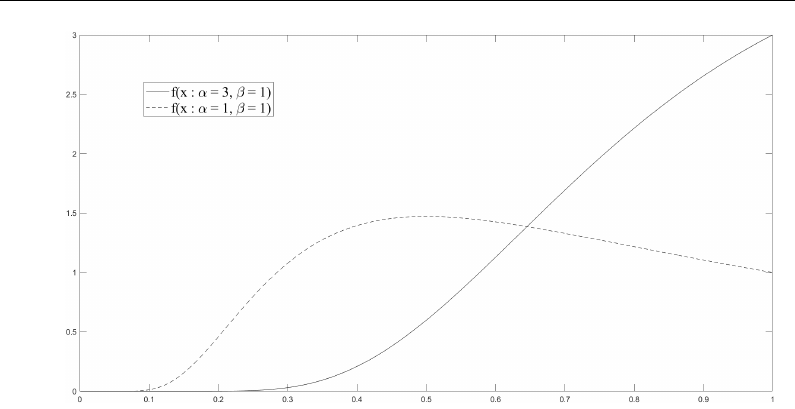
Figure 2 – Density functions of unit-Gompertz distribution for ( α = 3, β = 1 ) & ( α = 1, β = 1 ) . It is easy to see from Figure 2, that the mode of f ( x ; α = 3; β = 1 ) is at x = 1, while the mode of f ( x ; α = 1; β = 1 ) is at x = 0.5. We formalize this and now correct